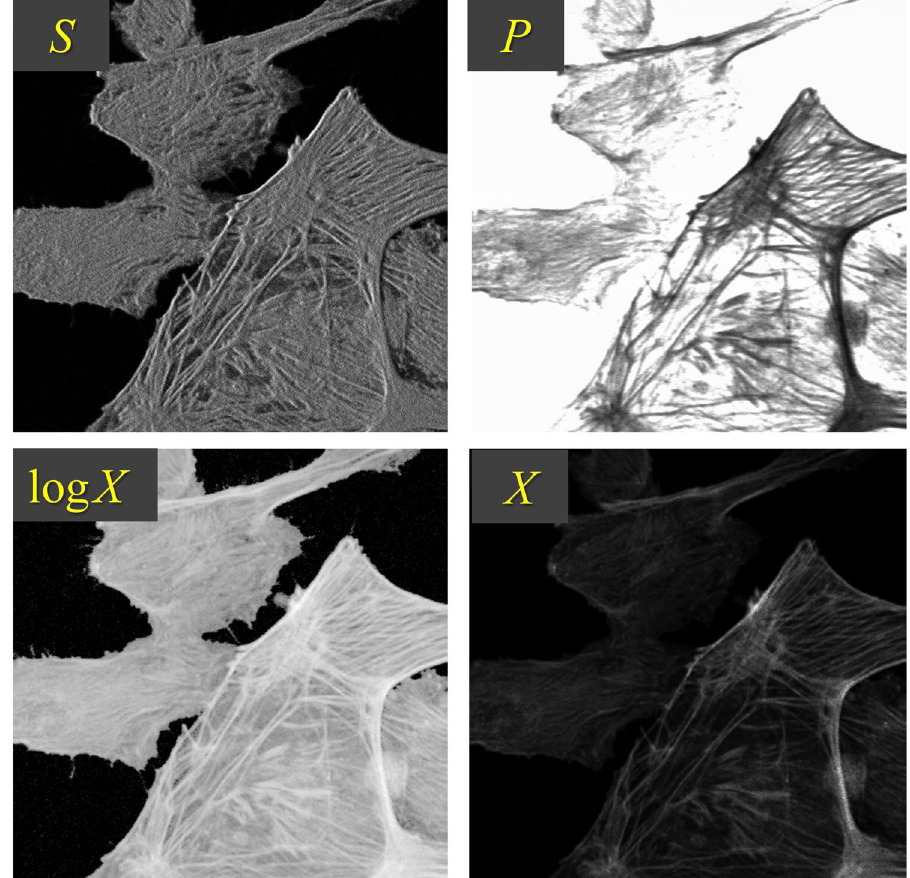
Figure 2. Demonstration of technique. S is the raw PMT data obtained from BPAE cells (FluoCells Prepared Slide 2, Molecular Probes) while active illumination is on (normally this signal would be sent to the microscope acquisition electronics). P is the illumination power measured by the photodiode. X log encoded sample strength sent to the microscope acquisition electronics. X is the linear-encoded sample strength calculated post-hoc (see below). Note the bright edges apparent in S are caused by overshoot in the feedback at 4 μ s pixel time (see Supplementary Information for details). These are canceled after computation of X log